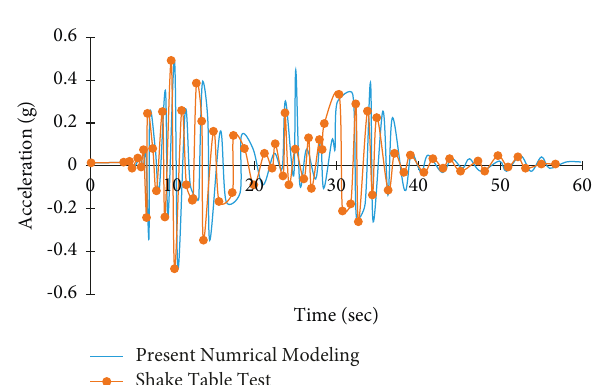
Figure 14: Acceleration history of the top frame.